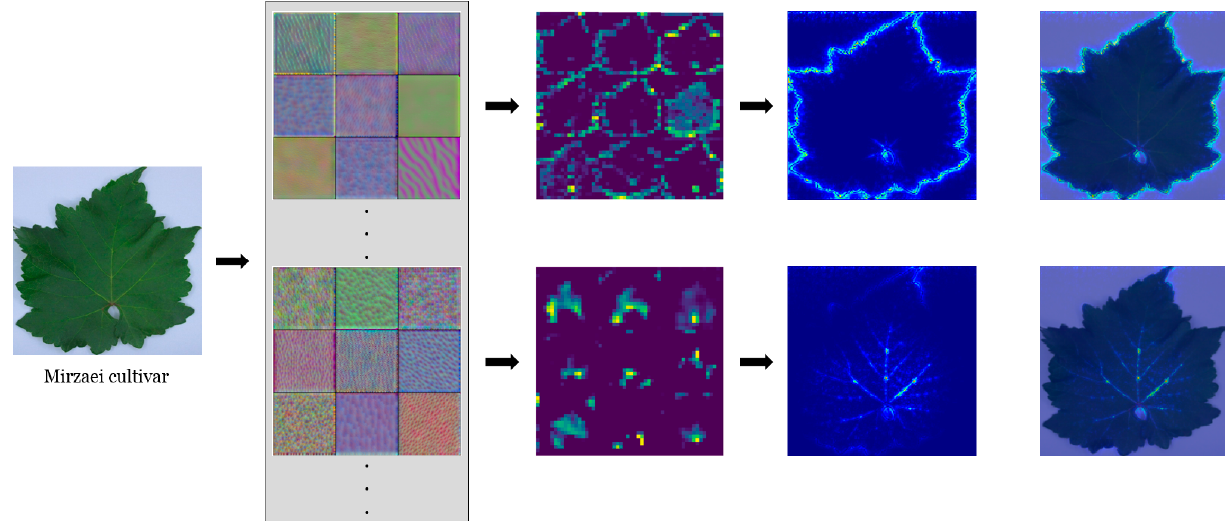
Figure 7. Filter response visualization in a representative leaf of one grapevine cultivar. Convolutional blocks with some filter banks (first dual panel), some channels of the activation layer (second dual panel), and class saliency maps (third and fourth dual panels).